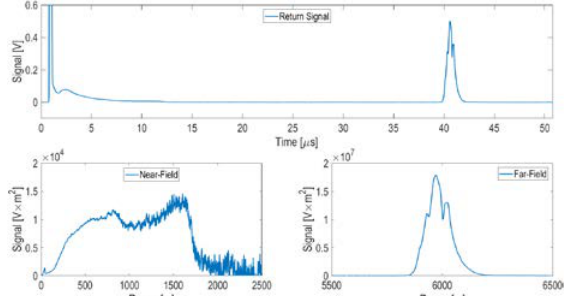
Figure 5. Sample profile of a far-filed cirrus cloud return at 2- µ m using MCT e-APD detection system (top) and the zoom-in range corrected signal for the near- field boundary layer (bottom left) and far-filed cloud structure (bottom